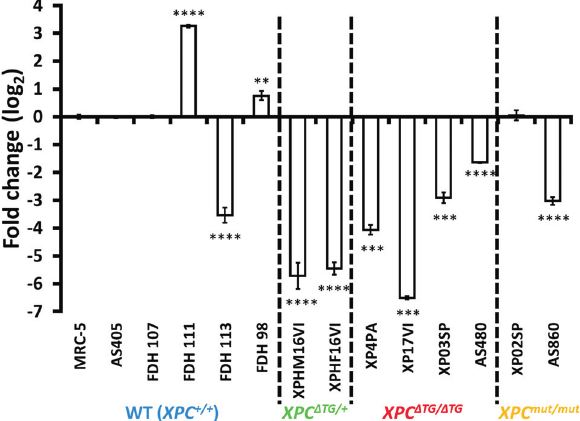
Figure 2 - Analysis of PGC-1 (cid:2) gene expression in 14 cell lines. PGC-1 (cid:2) expression of human primary fibroblasts and SV-40 immortalized human fibroblasts were accessed by RT-qPCR. XP4PA was matched with MRC-5 (mean±SD, n=4). Fibroblasts FDH98 (female), FDH111, FDH113, XPHM16VI, XP17VI (all male) were matched with FDH107 (male) (mean±SD, n=4). Male fibroblasts XP02SP and XP03SP were matched with AS405 (mean±SD, n=3). Female fibroblasts XPHF16VI, AS480 and AS860 were matched with FDH98 (mean±SD, n=3). *** p